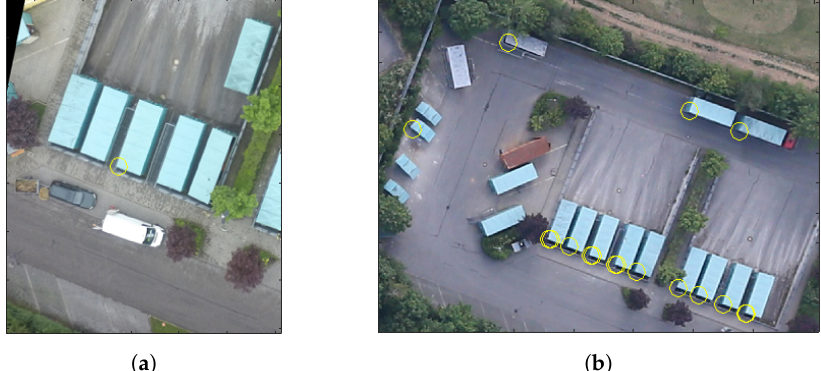
Figure 6. Challenge of ambiguous feature matching. One feature point at a corner of a container in the UAV image ( a ) corresponds to many feature points in the aerial image with similar descriptors ( b ). The correct match often can be found among a set of multiple nearest neighbors. These ambiguities need to be solved in order to extract the correct